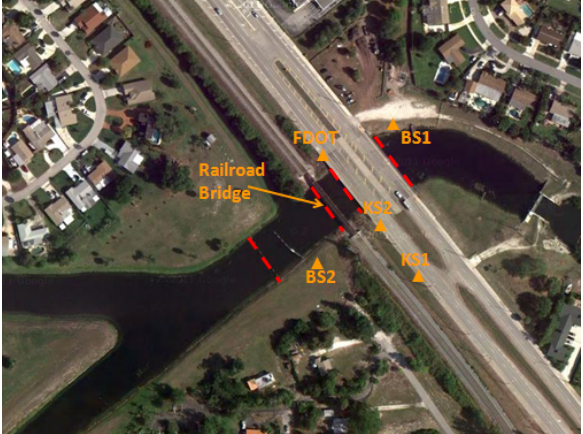
Figure 1: Aerial photo of project site, showing highway bridge, railroad bridge, and location of control points used. Dashed red lines show locations of lead line depth measurements (image from